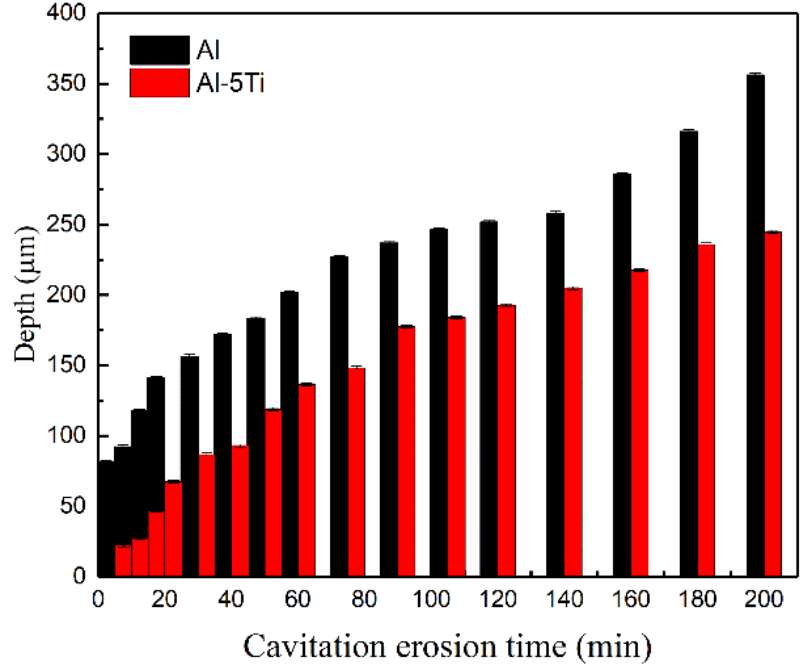
Figure 11. The histogram of the maximum depth of Al and Al-5Ti cavitation pits at different cavitation erosion times.